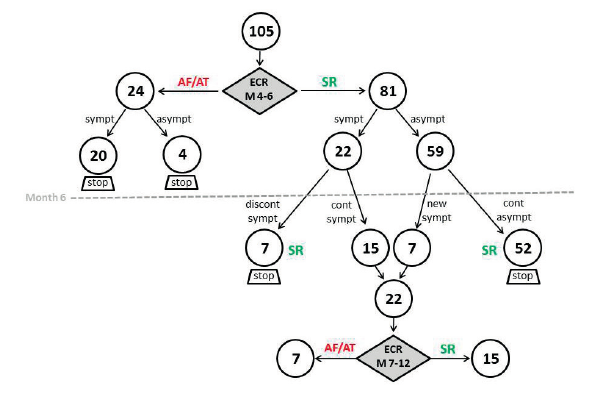
Fig. 2. Detection of first arrhythmia recurrence with episodic card